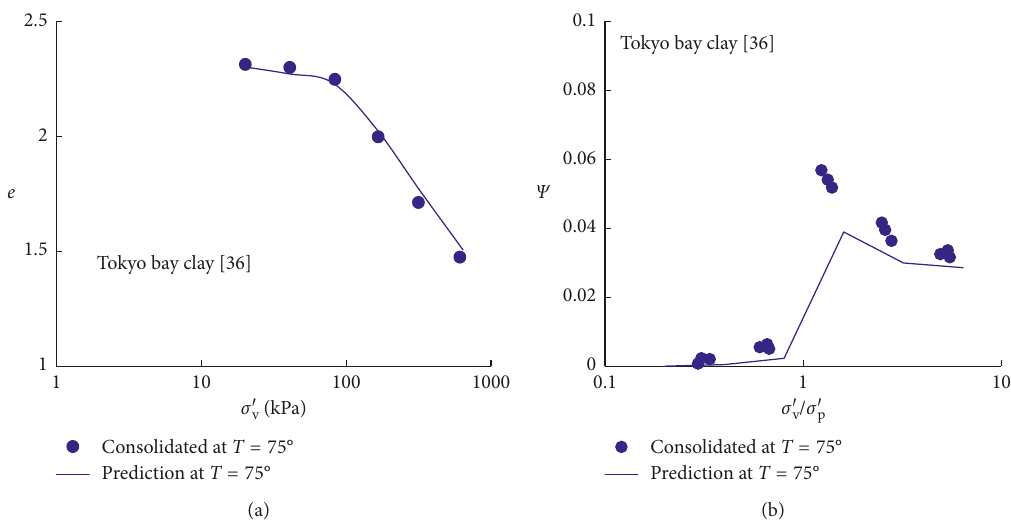
Figure 11: Predictions of the oedometer test on Tokyo bay clay consolidated at high temperatures: (a) compression curves; (b) creep coefficient versus normalized vertical